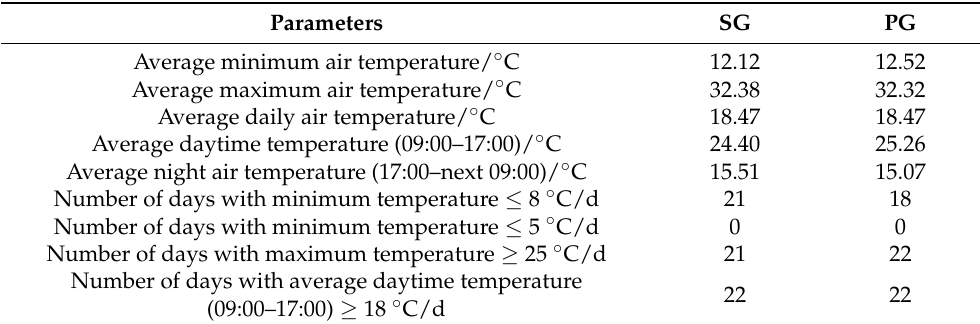
Table 3. Analysis of indoor monthly temperature in two greenhouses (31 January 2021 9:00–28 February 2021